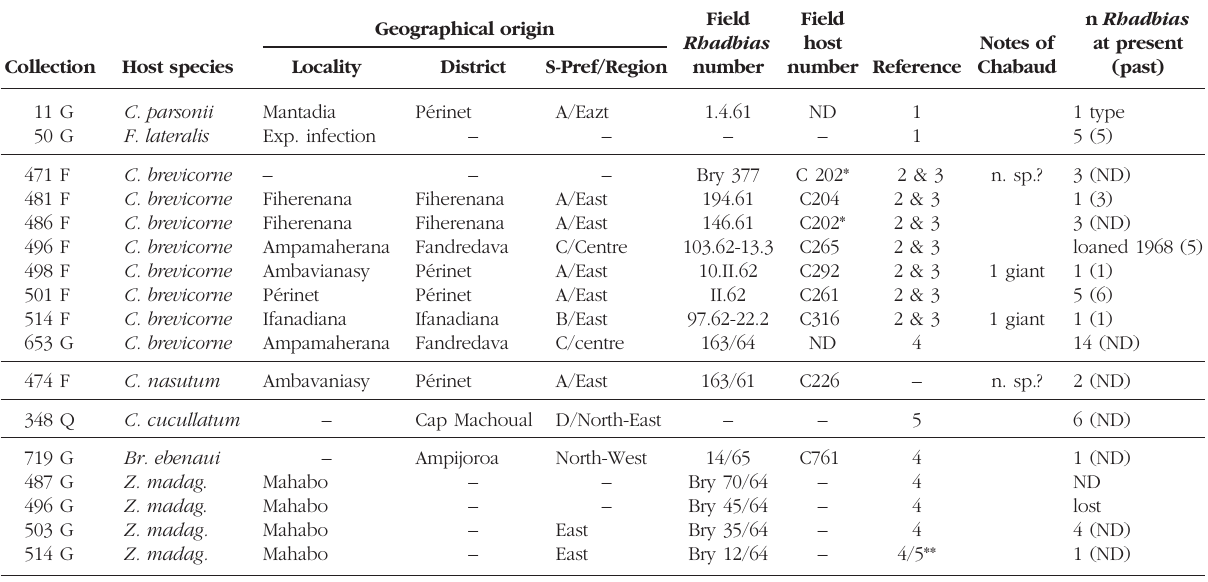
Table I. – Malagasy specimens of Rhabdias recovered from chameleonids and other lizards, in the collection of the Muséum National d’His- toire Naturelle, Paris, and identified as R. gemellipara Chabaud, Brygoo & Petter,